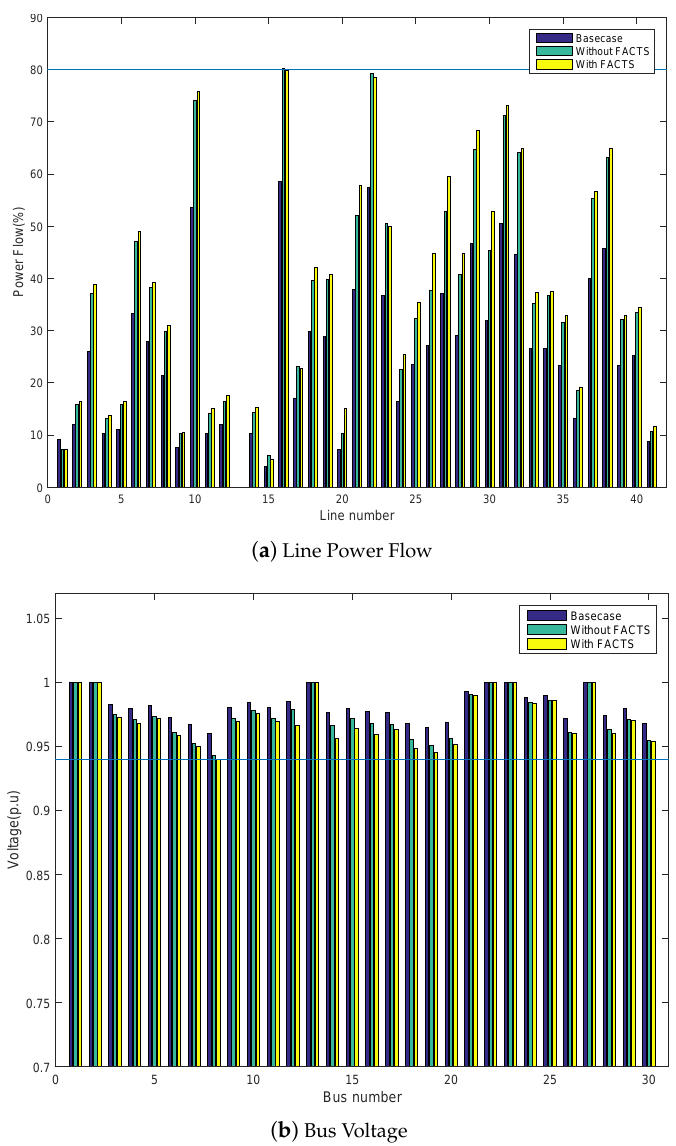
Figure 5. Line power flow and bus voltage of IEEE 30 bus